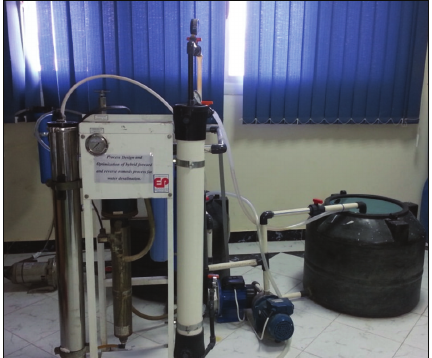
Figure 3: An image of the FO/RO pilot-scale